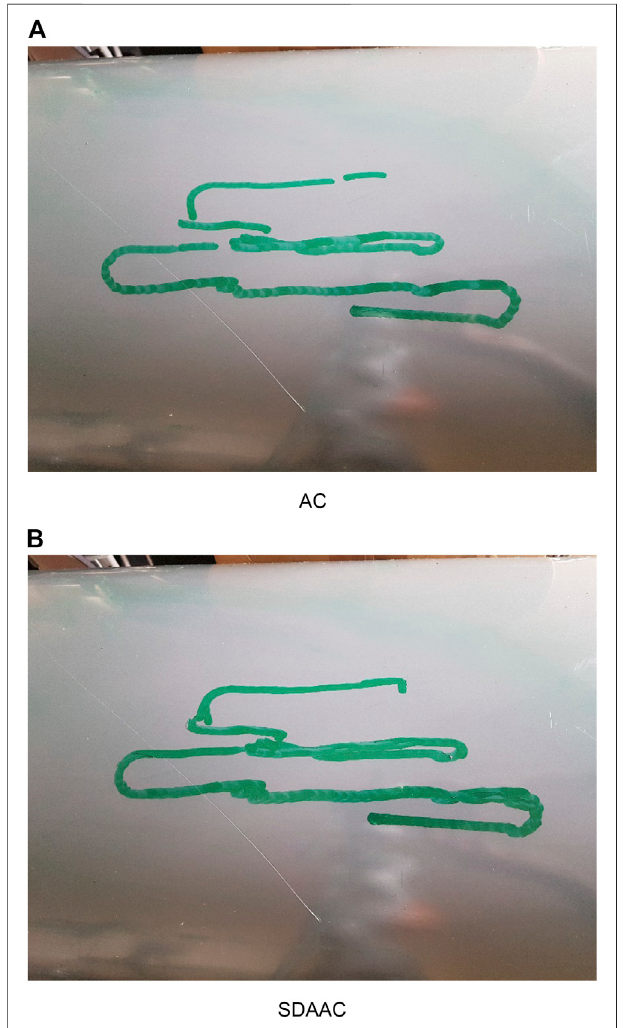
FIGURE 9 | Experimental results (drawings on the pipe) for real ROV base